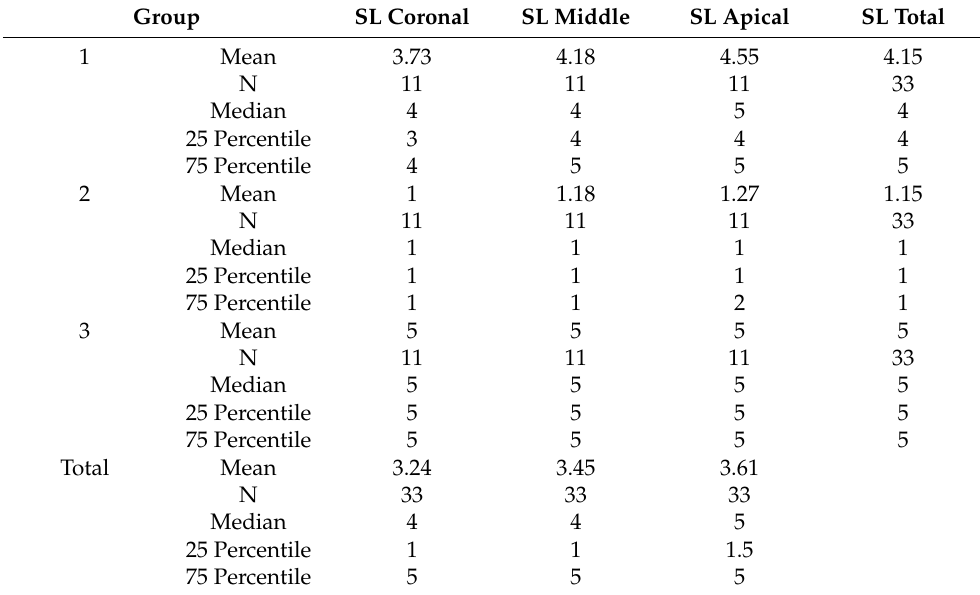
Table 2. Means, medians, 25 and 75 percentiles per group, SL: Smear